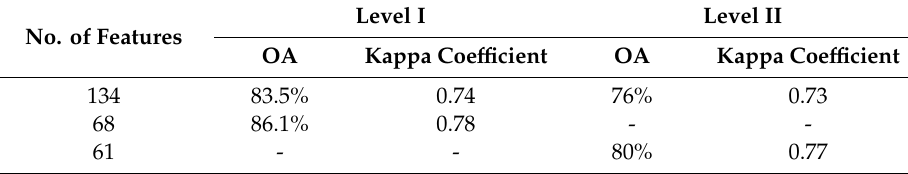
Figure 8. The classification overall accuracy with the varying number of features. Table 4. The classification accuracy before and after feature selection.